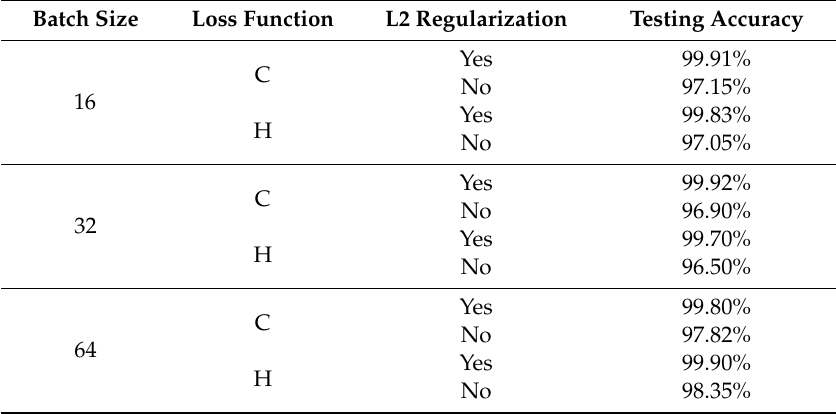
Table 2. Testing accuracy of di ff erent parameters selections in CNN.